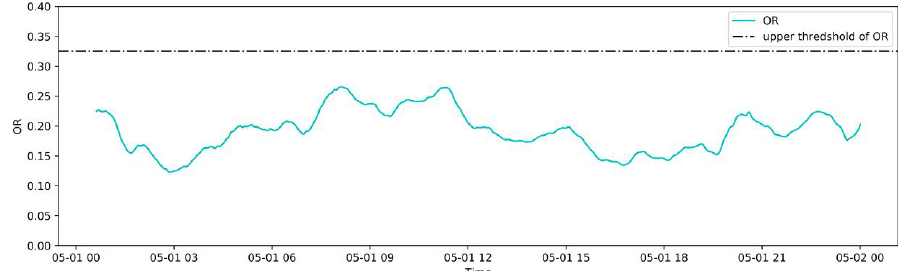
Figure 13. Real-time monitoring of the OR in a normal case.